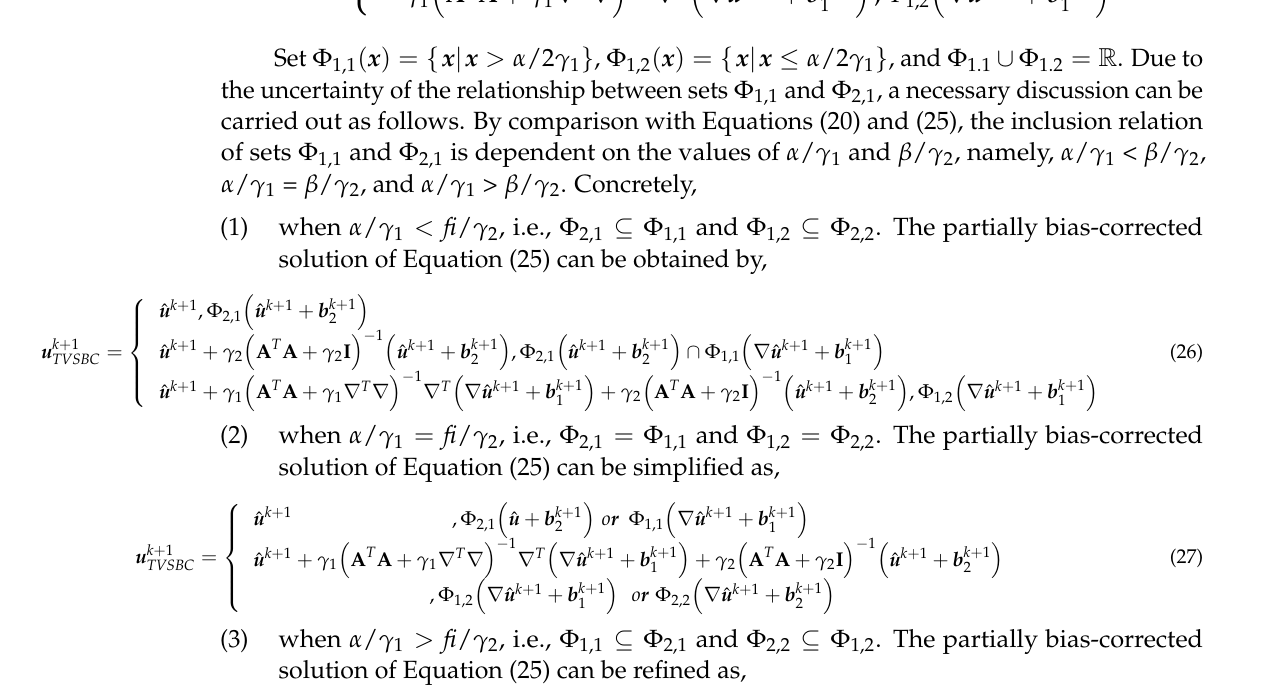
when α / γ 1 > fi / γ 2 , i.e., Φ 1,1 ⊆ Φ 2,1 and Φ 2,2 ⊆ Φ 1,2 . The partially bias-corrected solution of Equation (25) can be refined